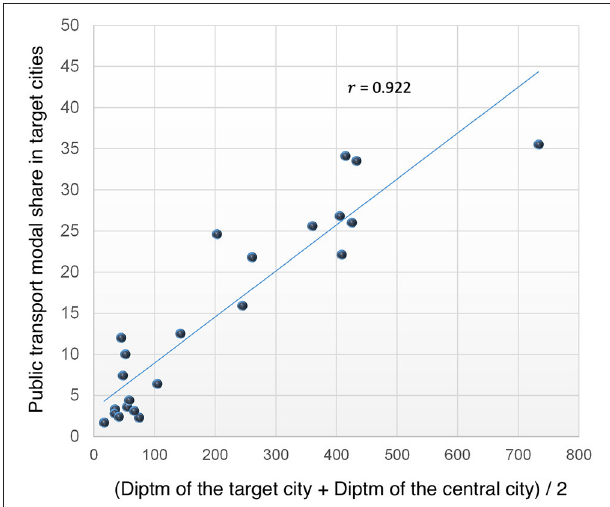
FIGURE 8 | Relationship between Diptm and modal share considering the impact of central